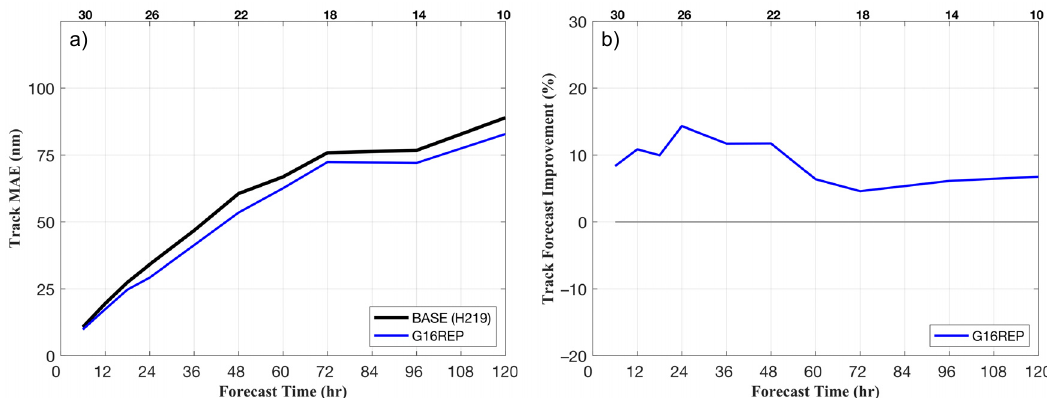
Figure 4. Hurricane Irma (2017) HWRF track forecast MAE (nm) verified against NHC Best Track for BASE (heavy black line) and G16REP (blue line) in ( a ). Percentage improvement in MAE relative to BASE is shown in ( b ). The number of verifying forecasts for each lead time is shown in black across the top of each plot.